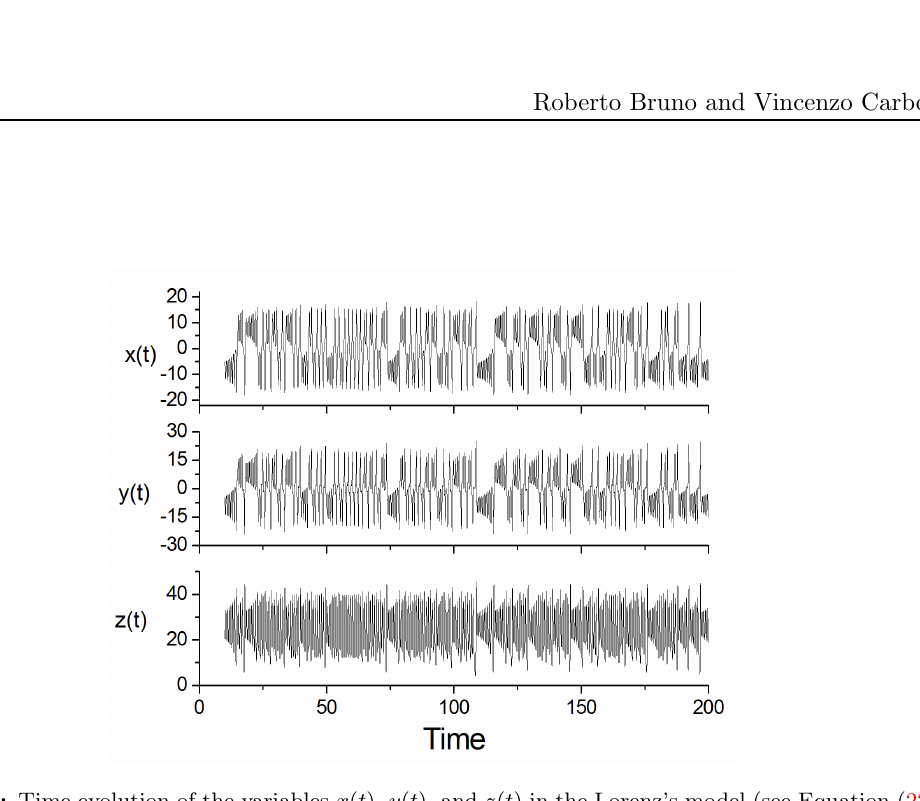
Figure 12: Time evolution of the variables 𝑥 ( 𝑡 ), 𝑦 ( 𝑡 ), and 𝑧 ( 𝑡 ) in the Lorenz’s model (see Equation (22)). This figure has been obtained by using the parameters 𝑃 r = 10, 𝑏 = 8 / 3, and 𝑅 = 28.